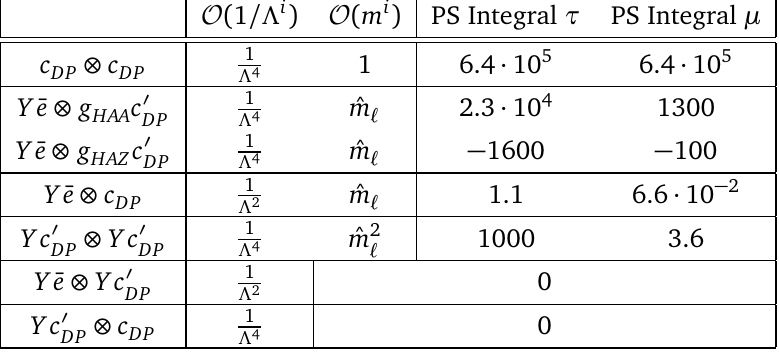
Table 6: Combinations of the dipole couplings and other couplings contributing to the partial width of the Higgs boson to two leptons and a photon, their leading con- tribution in the m (cid:96) expansion, and the size of the corresponding phase-space integral for the case of the tau and muon. The phase space integrations include the full mass dependence and are only expressed to two significant digits. Y is the Yukawa cou- plings proportional to the mass of the lepton, this lepton mass dependence is included in the phase space integral as is the ¯ e dependence. Entries for mass expansion of “0” indicate the amplitude squared is identically 0 (the two contributing amplitudes do not interfere). ( 1 / Λ i ) ( m i ) PS Integral τ PS Integral µ O O 1 ⊗ c c Λ 4 DP DP